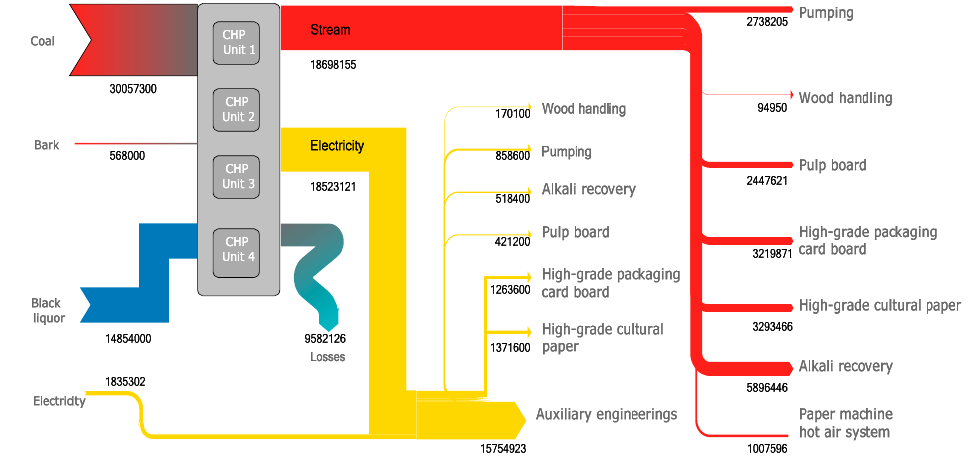
Figure 6. Energy flows in pulping and papermaking workshops (unit: GJ).